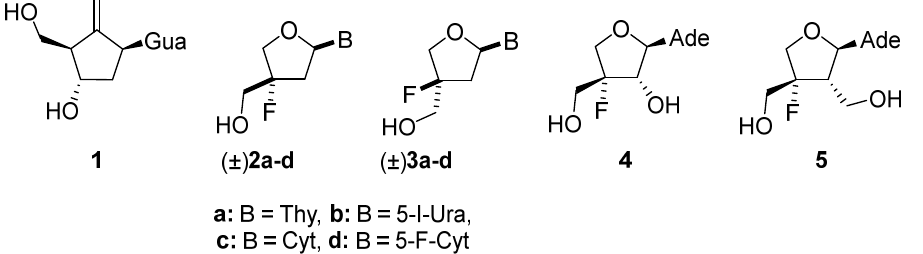
Figure 1. Structures of entecavir 1 and apionucleosides 2 – 5 .